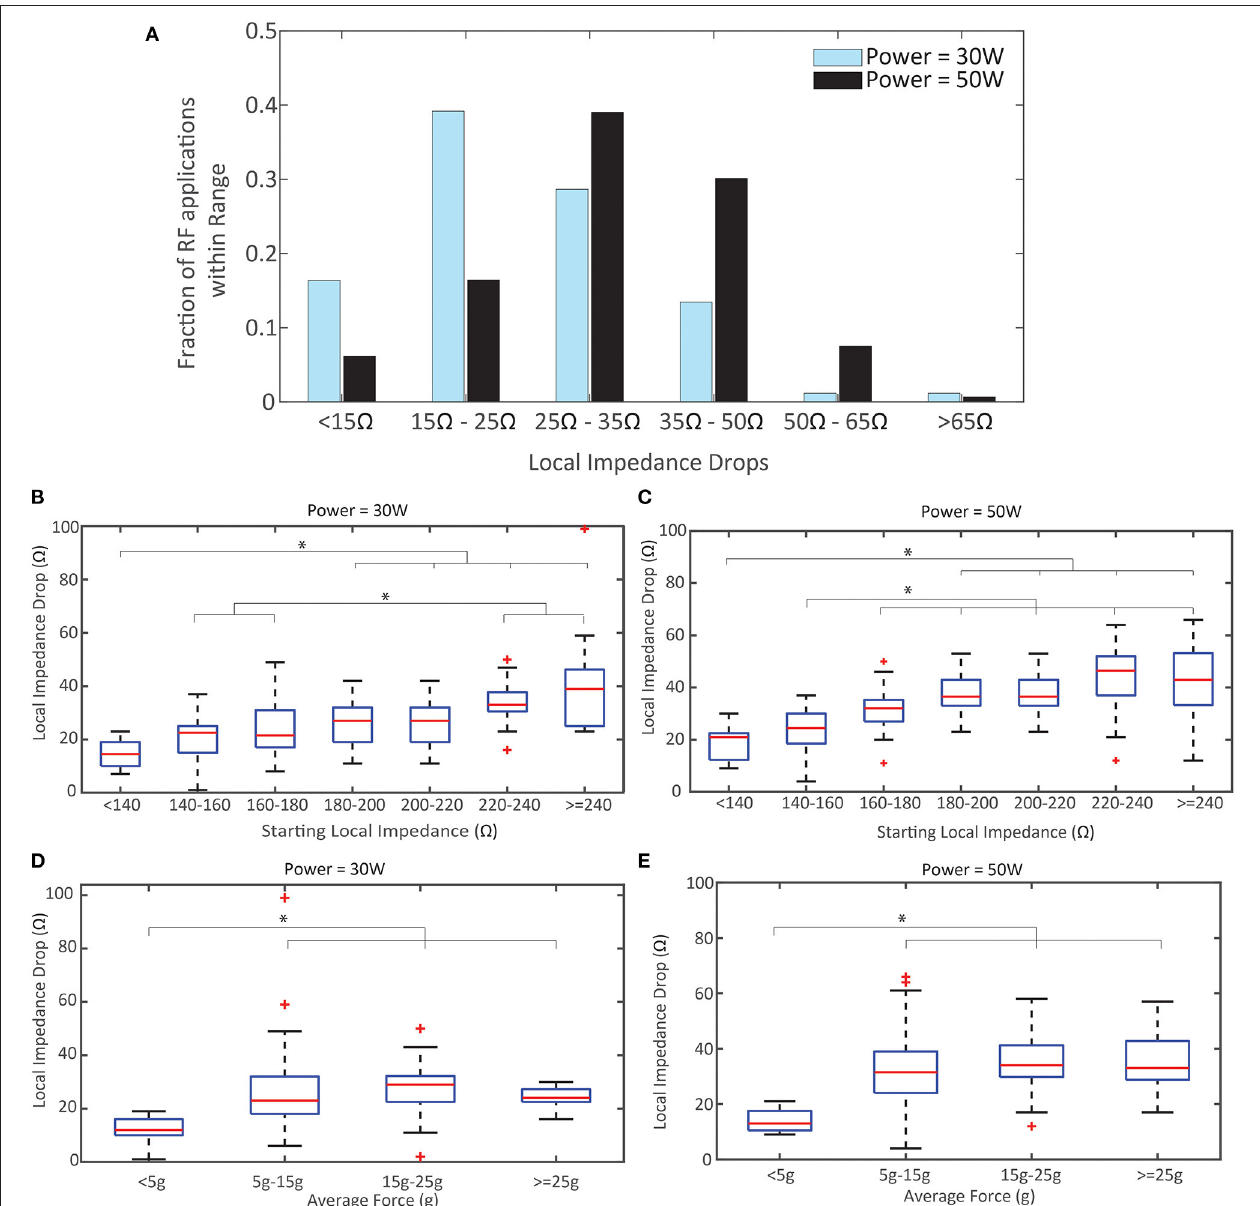
FIGURE 4 | Local Impedance Drop by Power, Starting Local Impedance, and Force. (A) Distribution of Local Impedance Drops in the 50W cohort compared to the 30W. (B,C) Local Impedance Drop distribution based on the starting local impedance for the 30W cohort (B) and 50W (C) . Both demonstrate a direct relationship. (D,E) Local Impedance Drop distribution based the contact force for the 30W cohort (D) and 50W (E) . Both demonstrate a plateau in effect once force ≥ 5g applied force. p < 0.001 for (B-D) ; p = 0.0059 for (E) . ∗ indicates statistical